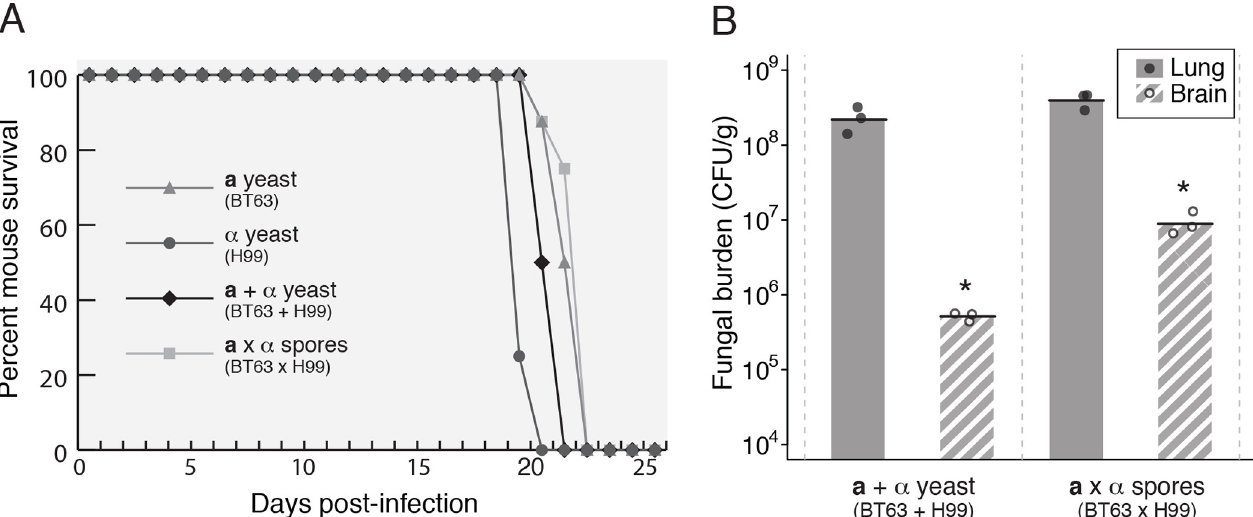
Fig 1. Spores result in higher fungal burdens in the brain than yeast in a mouse intranasal model of infection. (A) Representative survival plot of mice (8 per group) infected intranasally with 1x10 5 BT63 ( a ) yeast alone (triangles), 1x10 5 H99 ( α ) yeast alone (circles), 1x10 5 yeast as a 1:1 mixture of both strains (BT63 + H99; diamonds), or 1x10 5 spores derived from a cross between strains (BT63 x H99; squares). (B) Fungal burdens (as colony-forming units per gram of tissue) at endpoint in the lungs (gray bars) and brains (striped bars) of mice infected with 1x10 5 yeast in a 1:1 mixture of both parent strains (BT63 + H99) or with 1x10 5 spores derived from a cross between strains (BT63 x H99) (3 mice per group). Each circle represents an individual mouse. � p = 0.011 for brain comparisons; for lung and all other tissues, p � 0.10 (using a Student’s t-test). Data are representative of multiple biological replicates (see Materials and